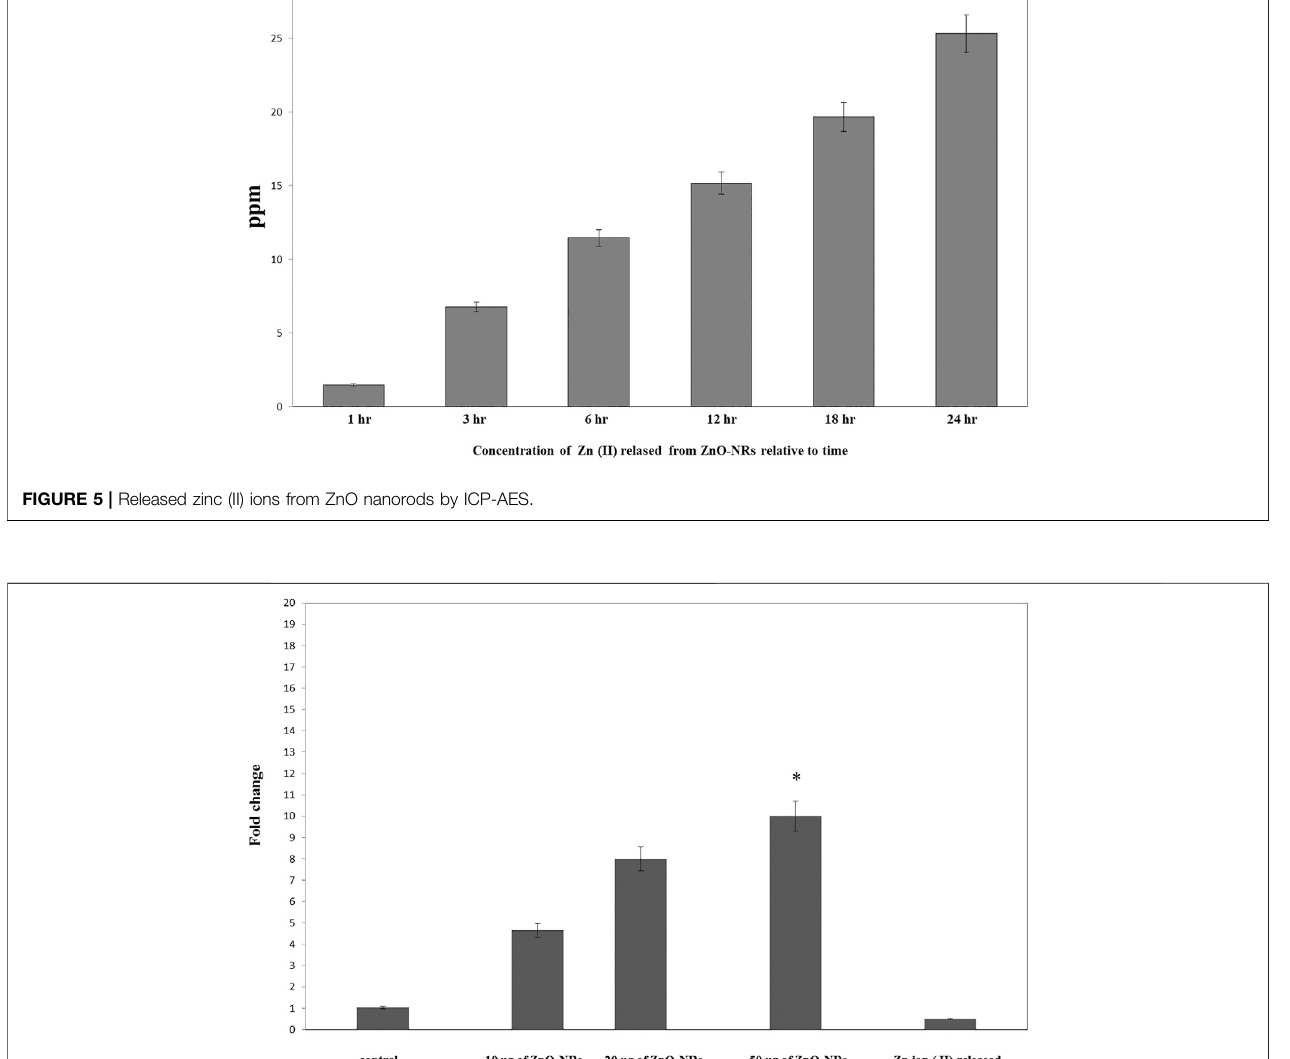
Frontiers in Pharmacology |